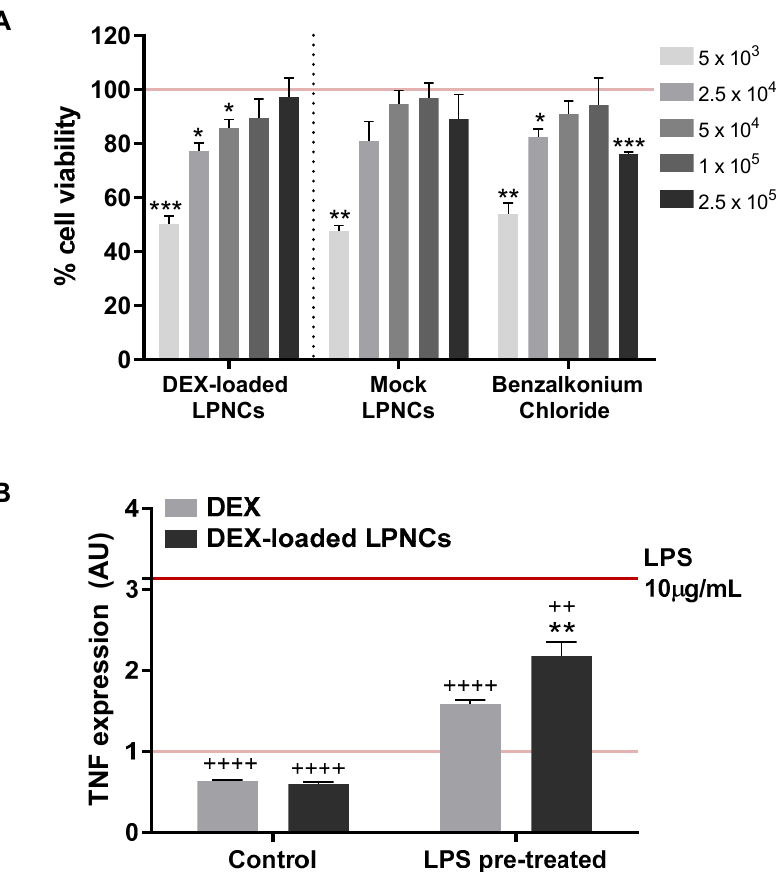
Figure 7. In vitro cell culture studies: ( A ) HEK001 cell viability with MTT assay. The indicated numbers represent the inverse dilution factors, referring to the composition of synthetized LPNCs. For DEX-loaded LPNCs, the dilution factors correspond to the concentrations of 5, 1, 0.5, 0.25, and 0.1 µM of DEX. For benzalkonium chloride, proper concentrations were 1, 0.2, 0.1, 0.05, and 0.02 µM. Data are represented as the mean ± SEM ( n = 3) of the cell viability percentage, referring to untreated controls (horizontal lane). Statistical significance was assessed by Student’s paired t-test; * p < 0.05; ** p < 0.01; *** p < 0.005. ( B ) TNF α mRNA expression was measured after treating cells for 24 h with 0.1 µM of either free dexame- thasone (grey) or DEX-loaded LPNCs (dark gray), without (left) or with (right) a 1-h pre-treatment with LPS (10 µg/mL). TNF α expression is represented as the mean ± SEM ( n = 3); TNF α expression at control and LPS treatment conditions is indicated with horizontal pink and red lanes, respectively. Statistical significance was evaluated by one-way ANOVA compared to the control (*) or LPS (+); ** p < 0.01, ++ p < 0.01, ++++ p < 0.001.